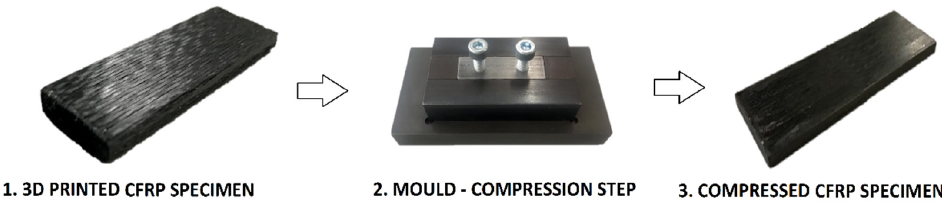
Figure 2. Iterative procedure for determining optimal post-processing parameters.